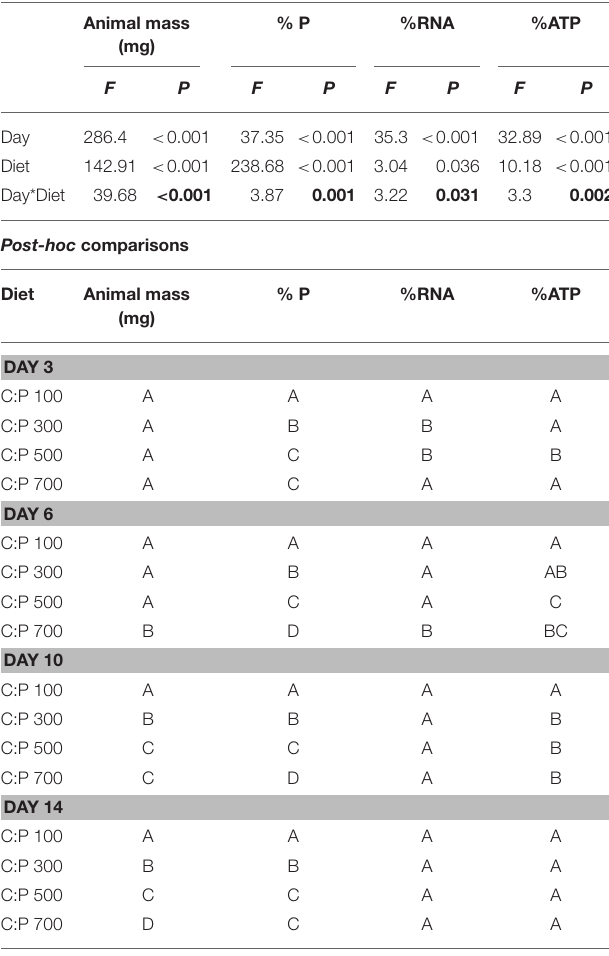
decreased steadily over time when animals were switched from C:P 100 to high C:P diets ( Figure 2C ). Daphnia switched from C:P 100 to higher C:P diets (C:P 300 and C:P 700)